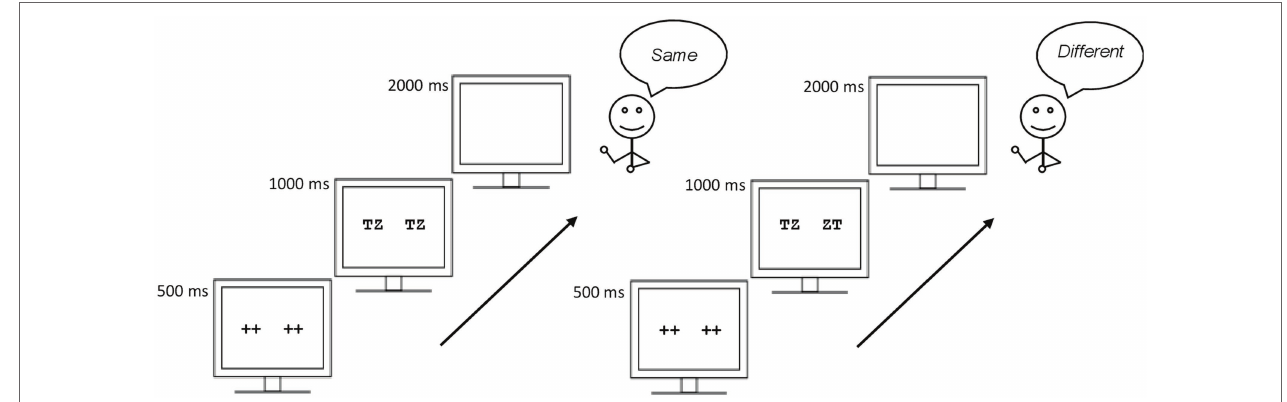
FIGURE 1 | Depiction of the same-different task used in the Perea et al. (2016)